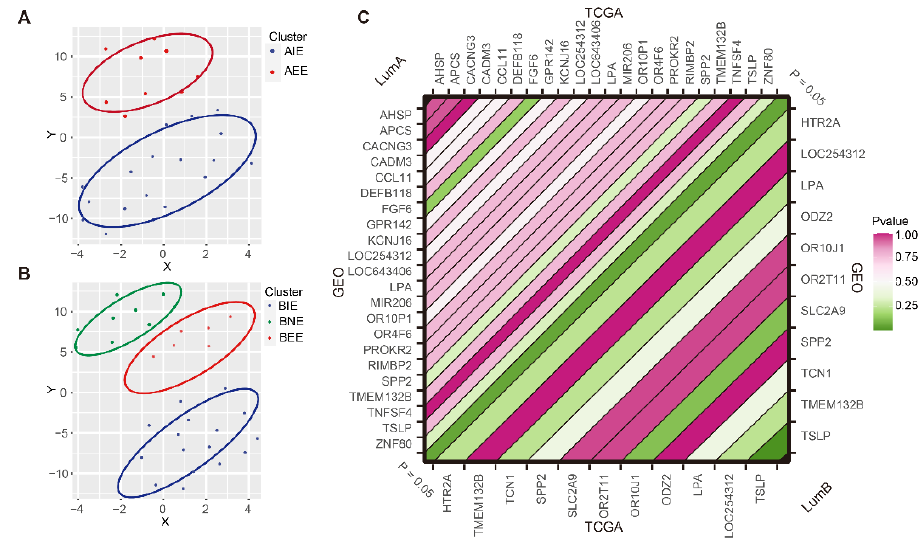
Figure 6. The subgroups in GEO dataset and TCGA data. ( A ) TSNE showed luminal A subgroups in GEO. ( B ) TSNE showed luminal B subgroups in GEO. ( C ) The concordance of distribution on DNA methylation gene levels in TCGA and GEO dataset.